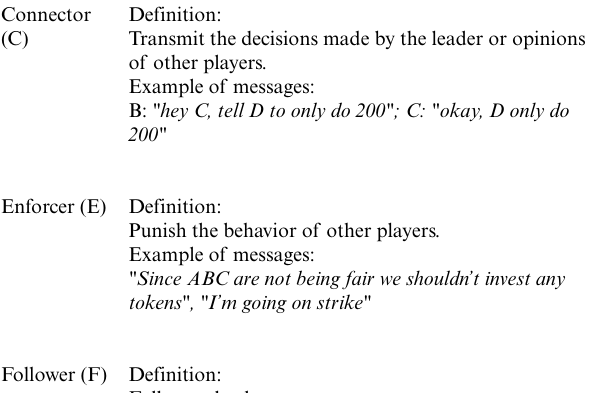
Table 1 . Definition of social roles and example of the type of messages used to code them.